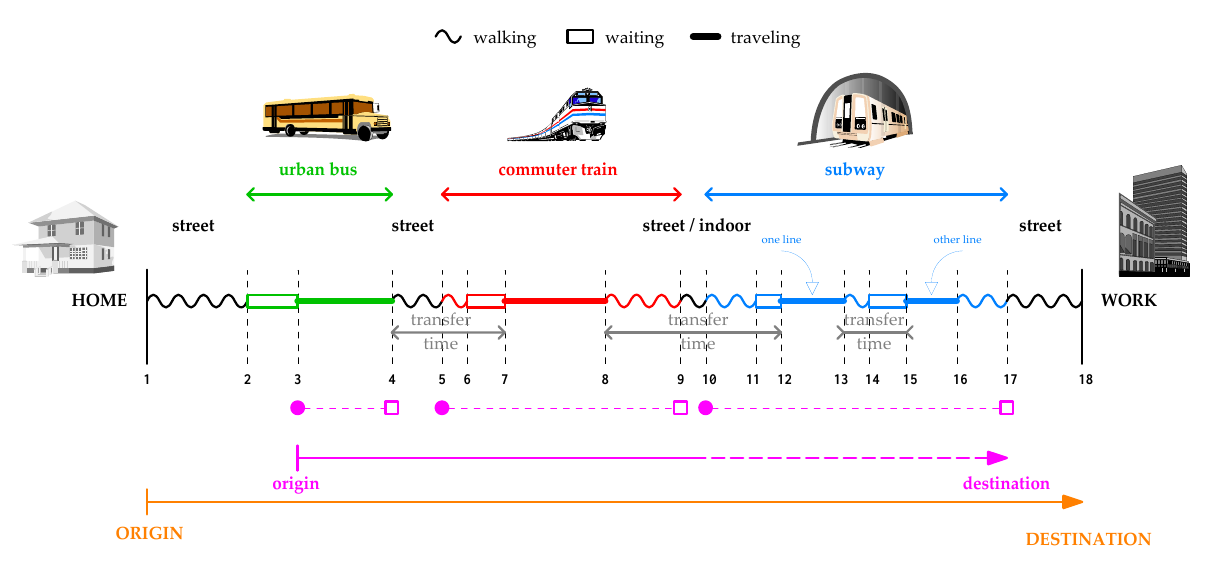
Figure 1. Schematic drawing of a complete